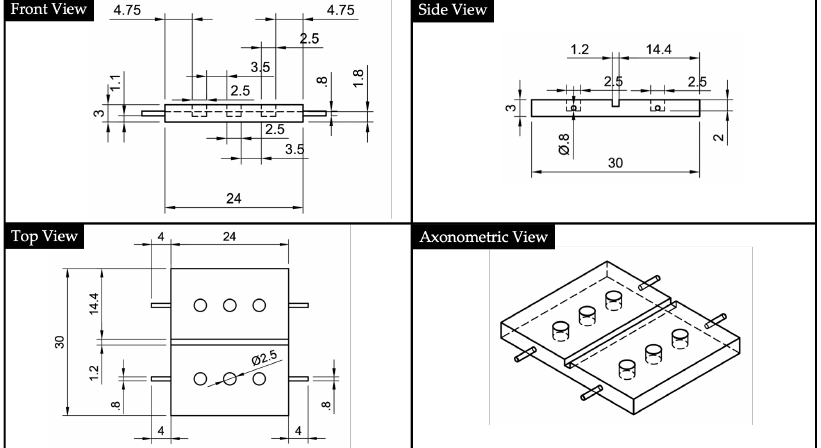
Figure 4. 2D drawings and North-West (NW) axonometric view of the bottom part (i.e., substrate).